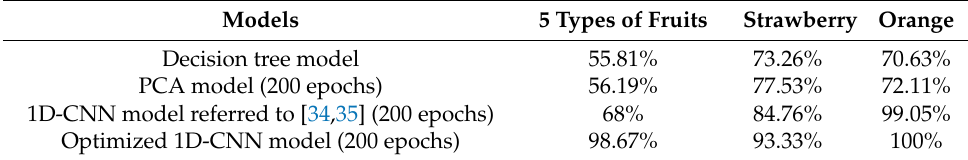
Table 2. Five-fold cross-validation recognition accuracy in the robustness dataset.